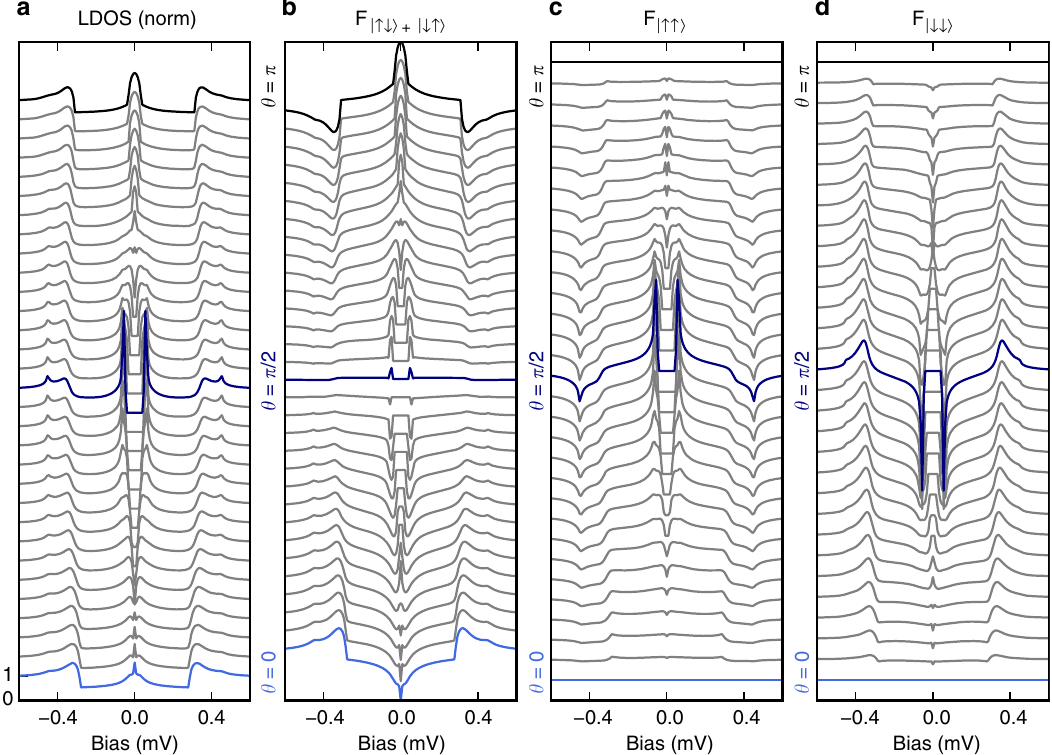
Fig. 2 Dependence of the superconducting properties on the magnetic con fi guration. a Evolution of the local density of states (LDOS) as a function of the relative angle θ between the magnetisation of the ferromagnetic connector and the G ϕ term of the S-node, showing zero-bias peaks with varying amplitude for parallel ( θ = 0) and anti-parallel ( θ = π ) alignment and the appearance of the triplet gap around perpendicular alignment. b Pair amplitude of the mixed- spin and c , d the equal-spin components as a function of θ . The mixed-spin component is prominent for θ ≈ 0 and θ ≈ π and almost vanishes around θ = π / 2, whereas for the equal-spin component it is opposite. All curves have been offset vertically for better